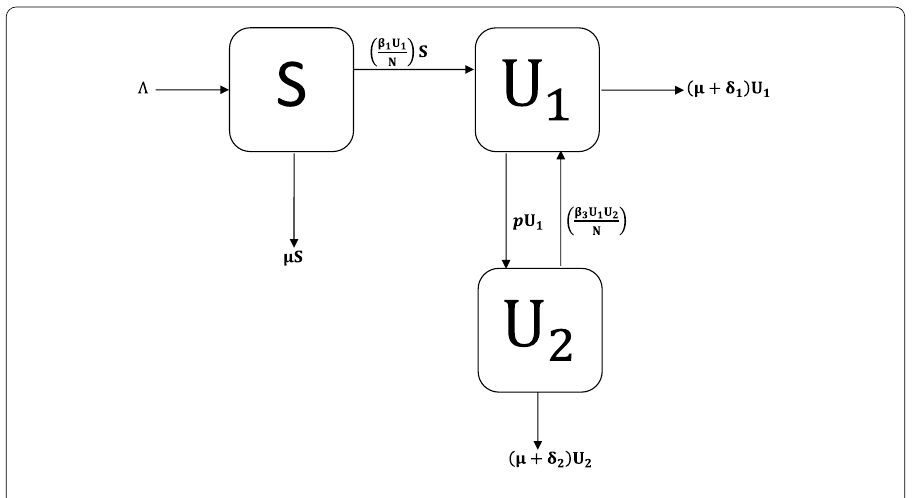
Figure 1 Flow diagram of heroin epidemic